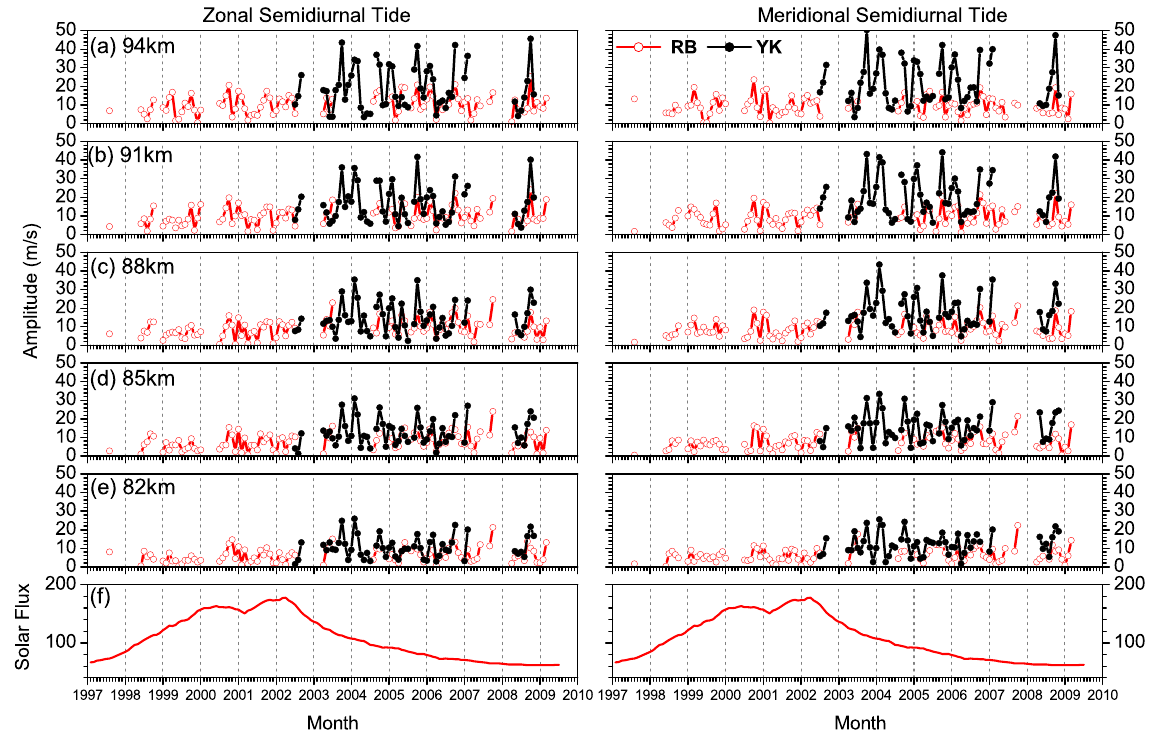
Fig. 6. Similar to Fig. 3, but for semidiurnal tidal amplitudes.